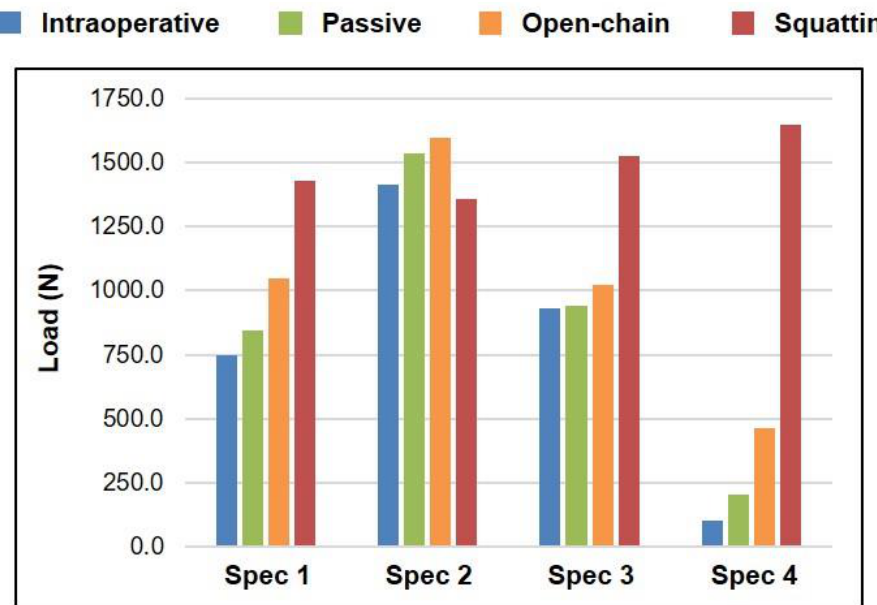
Figure 3. Peak total intra-articular load (sum of loads measured in the medial and lateral compart-